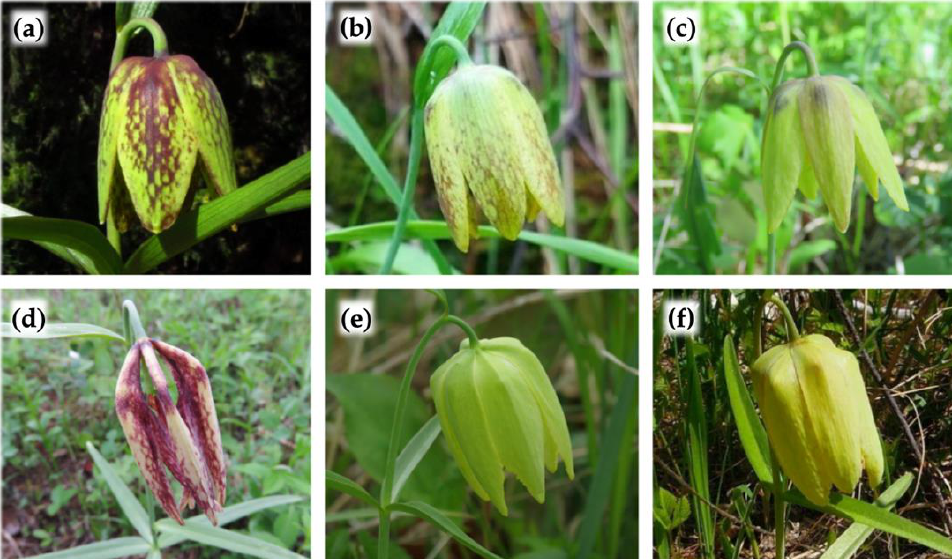
Figure 7. Different color morphs of the studied Fritillaria species. ( a ) F. dagana , the form with the perianth brown-purple on the exterior (photo by N.V. Stepanov, locality WS1); ( b ) F. dagana , the form with the light-colored perianth on the exterior (photo by D. Chimitov) [57]; ( c ) F. dagana , light-yellow-colored morph (photo by I.Yu. Selyutina, locality ES3); ( d ) F. maximowiczii , the common form with the perianth purple on the exterior (photo by D.V. Sandanov, locality DA1, late flowering stage); ( e ) F. maximowiczii , the form with the light perianth on the exterior (photo by V. Arkhipov) [58], ( f ) F. sonnikovae , the light-yellow form from locus classicus (photo by L. Bel’mas) [59]. Colorless perianth forms are also known for other species, e.g., in F. meleagris,